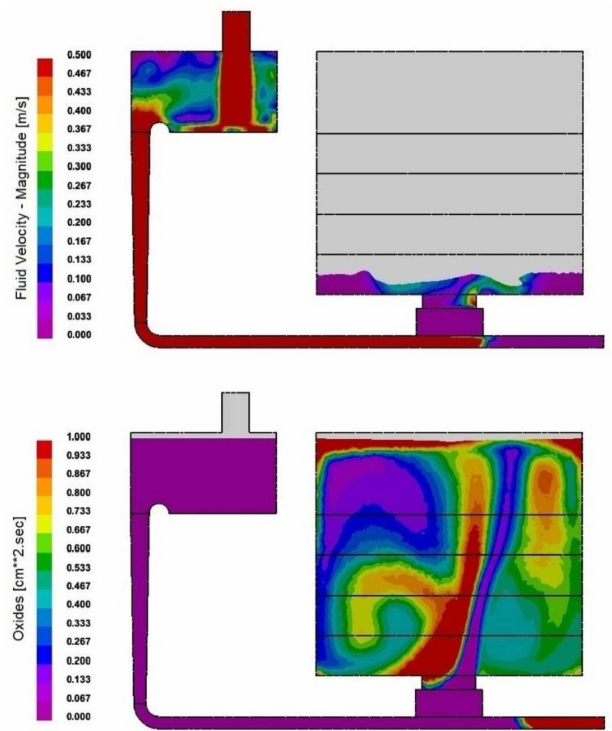
Figure 6. Simulations of the melt velocity and amount of oxides in the naturally pressurized gating system with 10 ppi foam